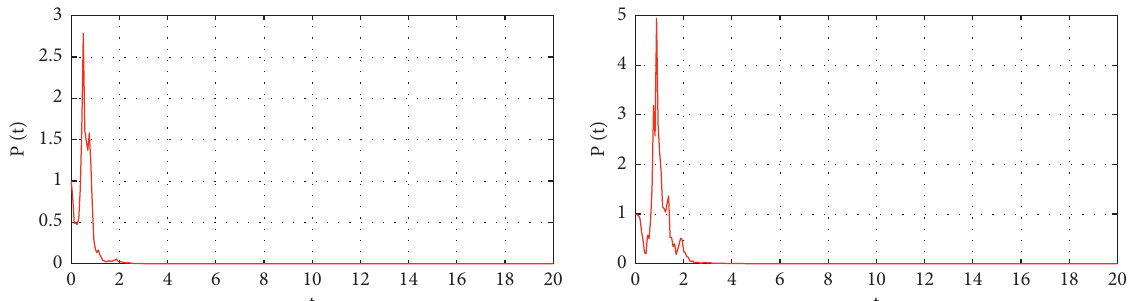
2.5 2 00.511.5 Figure 5: The trajectories of system (91) with P are almost surely exponentially stable for both (a) and (b) in the sense of Theorem 5 (iii).